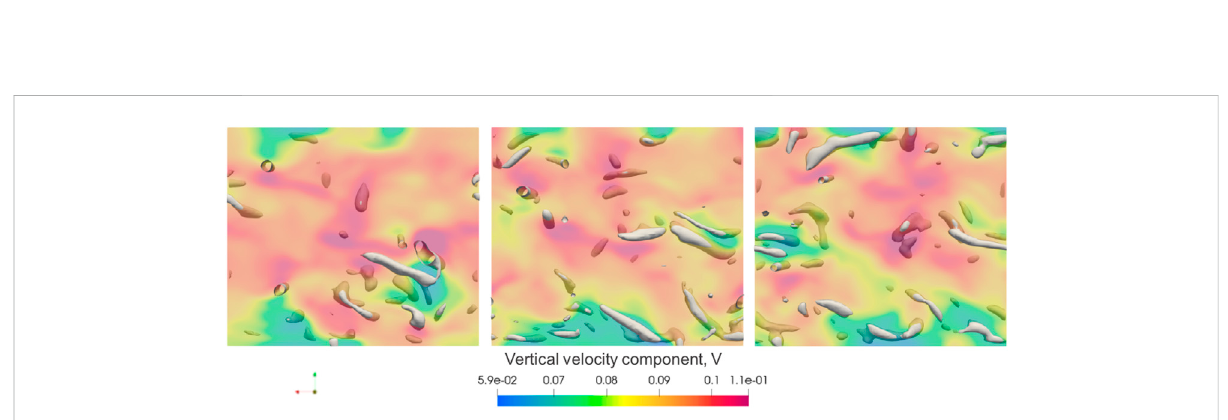
FIGURE 13 TopviewusingLambdawiththreshold=10.Selectedframesat23.68,36.0and36.9 sfromlefttoright.Colouredbyverticalvelocity.Horizontal plane taken 2.5 mm below the free surface. Areas of vertical velocity appear to correlate with the presence of local turbulent